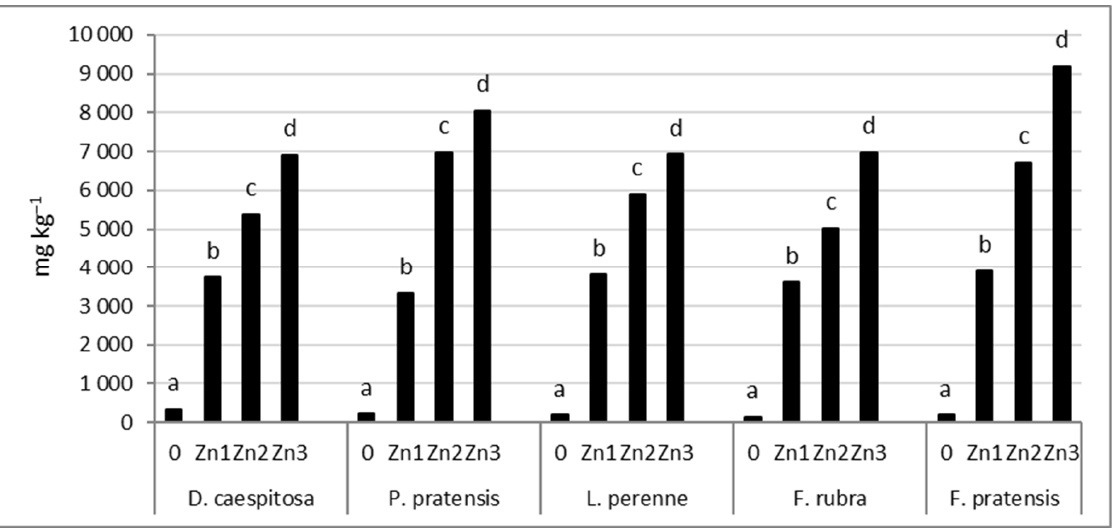
Figure 7. Zn concentration in roots. Values marked with the same letters within one species do not differ significantly, according to Tukey’s test ( p < 0.05).